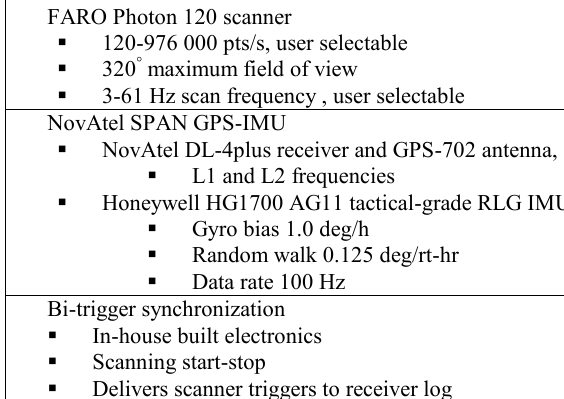
Table 1. ROAMER MLS system equipment and characteristics.